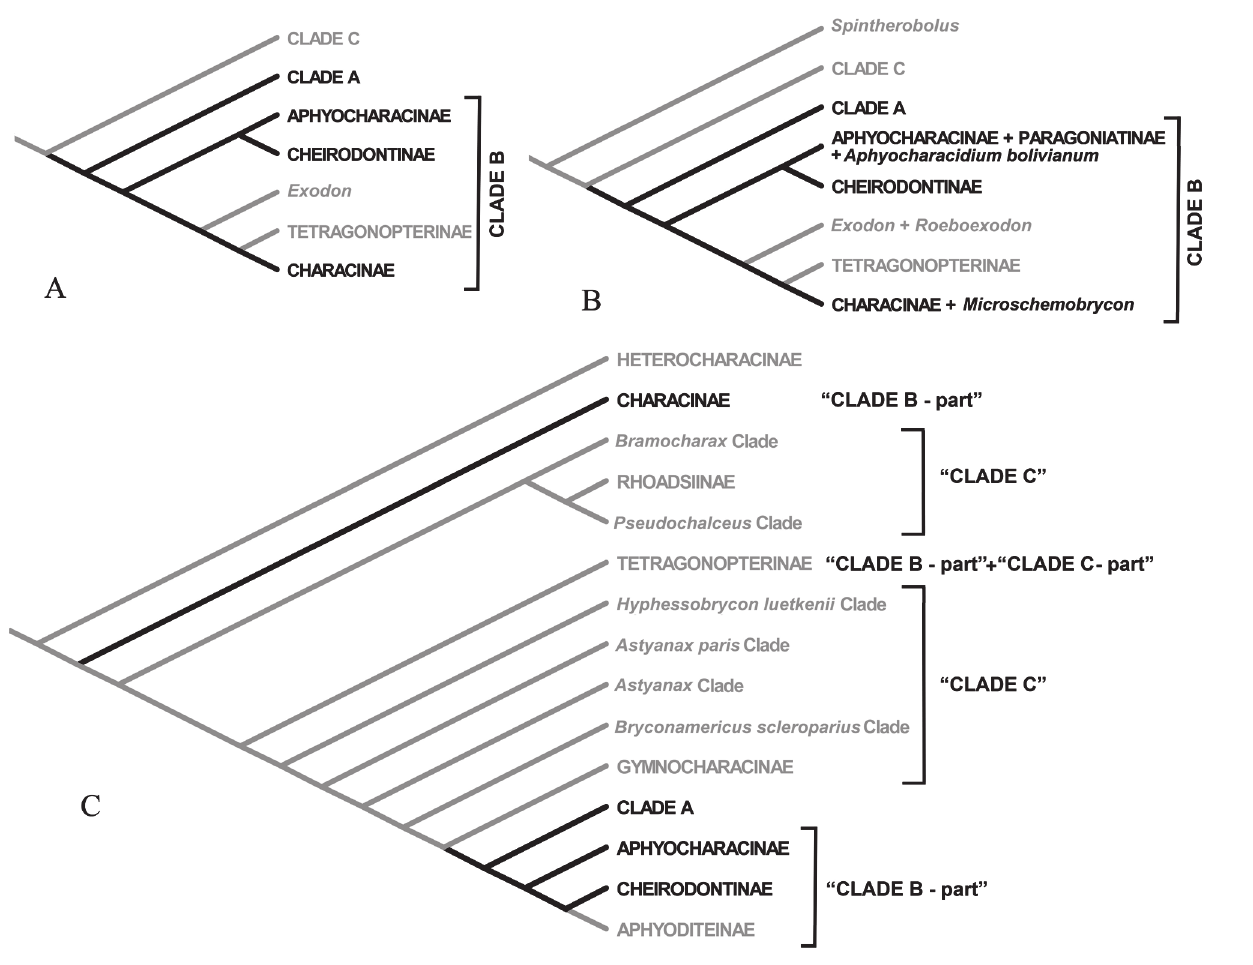
Fig. 7. Phylogenetic relationships among characid fishes lacking the supraorbital bone, as hypothesized by A ) Javonillo et al. (2010), B ) Oliveira et al. (2011), and C ) Mirande (2010). Black lines represent lineages containing species documented to have gill glands. Gray lines represent lineages without records of gill glands. Clades A, B, and C as defined by Javonillo et al. (2010) and Oliveira et al. (2011) are marked in Mirande’s (2010) hypothesis for comparison. Tetragonopterinae sensu Javonillo et al. (2010) and Oliveira et al. (2011) includes a single genus, Tetragonopterus . Tetragonopterinae sensu Mirande (2010) includes Tetragonopterus plus 18 genera assigned to Clade C by Javonillo et al. (2010) and Oliveira et al. (2011)